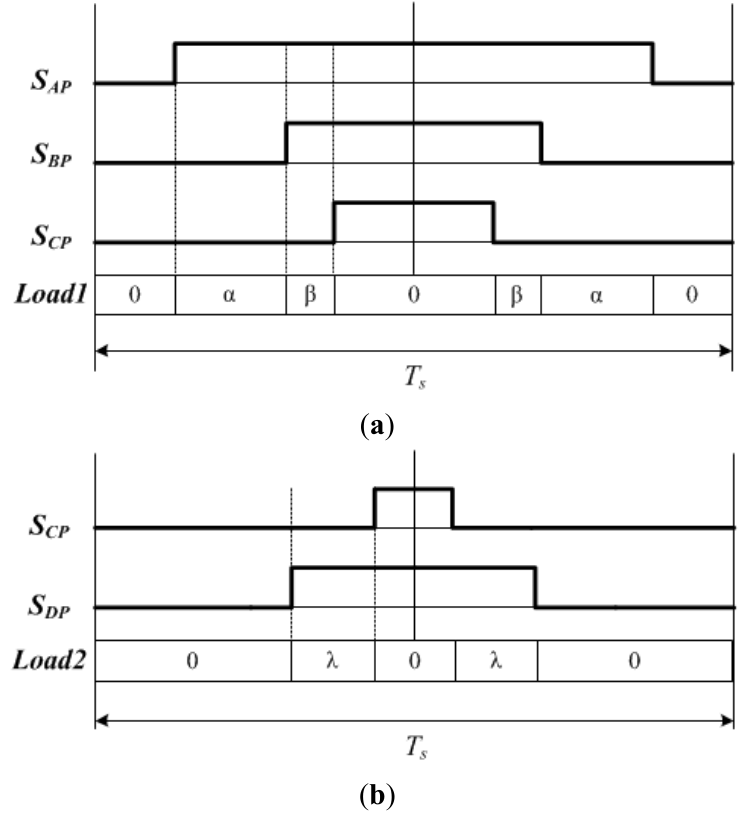
Figure 5. Switching state of the inverter stage: ( a ) considering only the three-phase load; ( b ) considering only the single-phase